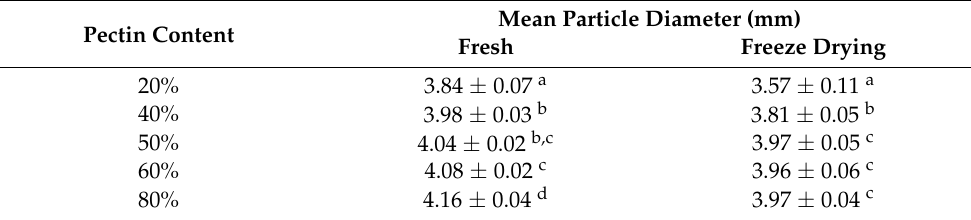
Table 1. Mean particle diameters (mm) for emulsion beads produced by different contents of pectin before and after freeze drying. Different letters (a to d) indicate significant differences (p ≤ 0.05).